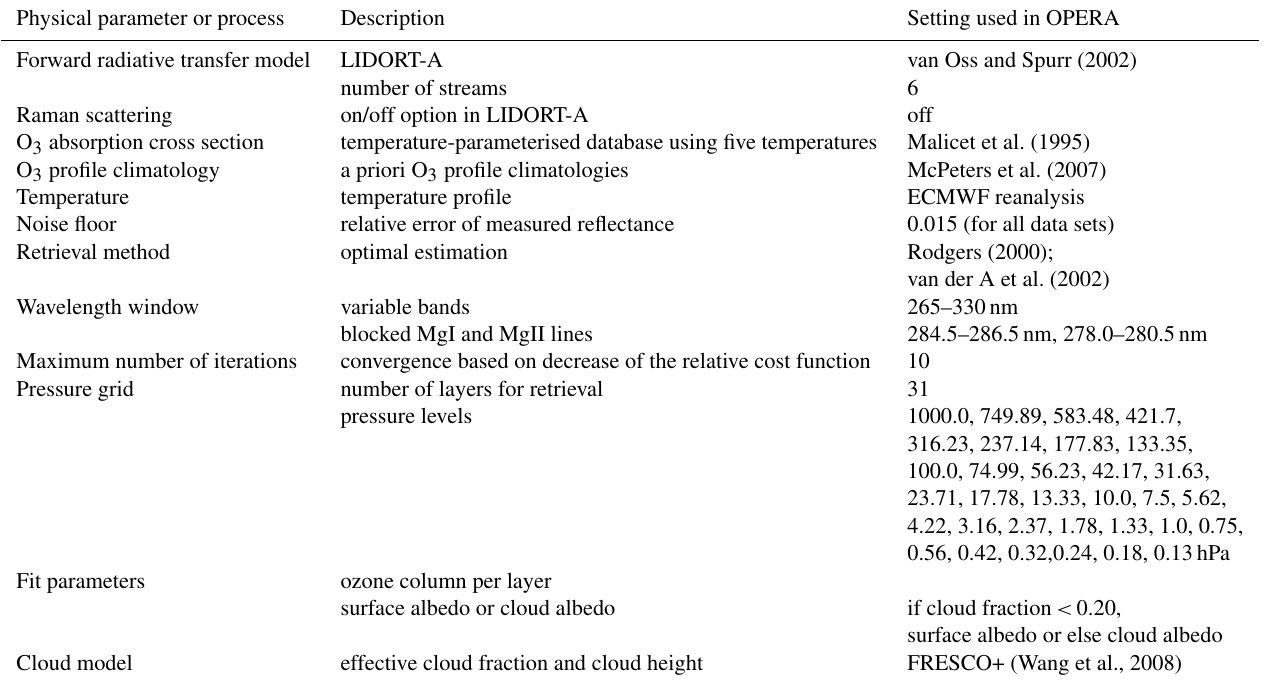
Table 2. Parameter settings in the OPERA algorithm for SCIAMACHY nadir O 3 profile